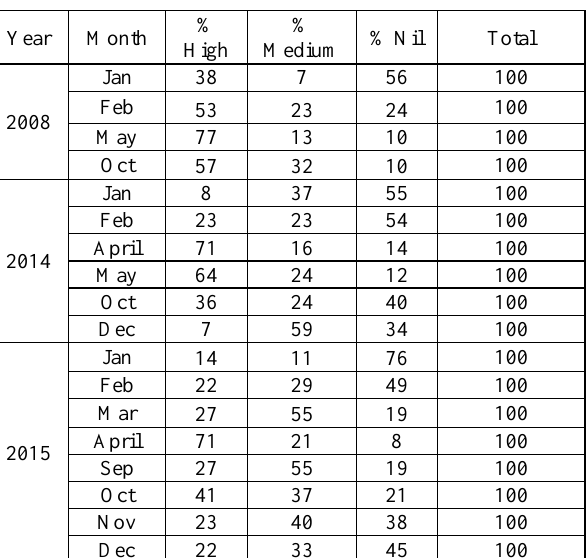
Table 1. spread of contamination in Nagarjuna Sagar reservoir in Sq. Km